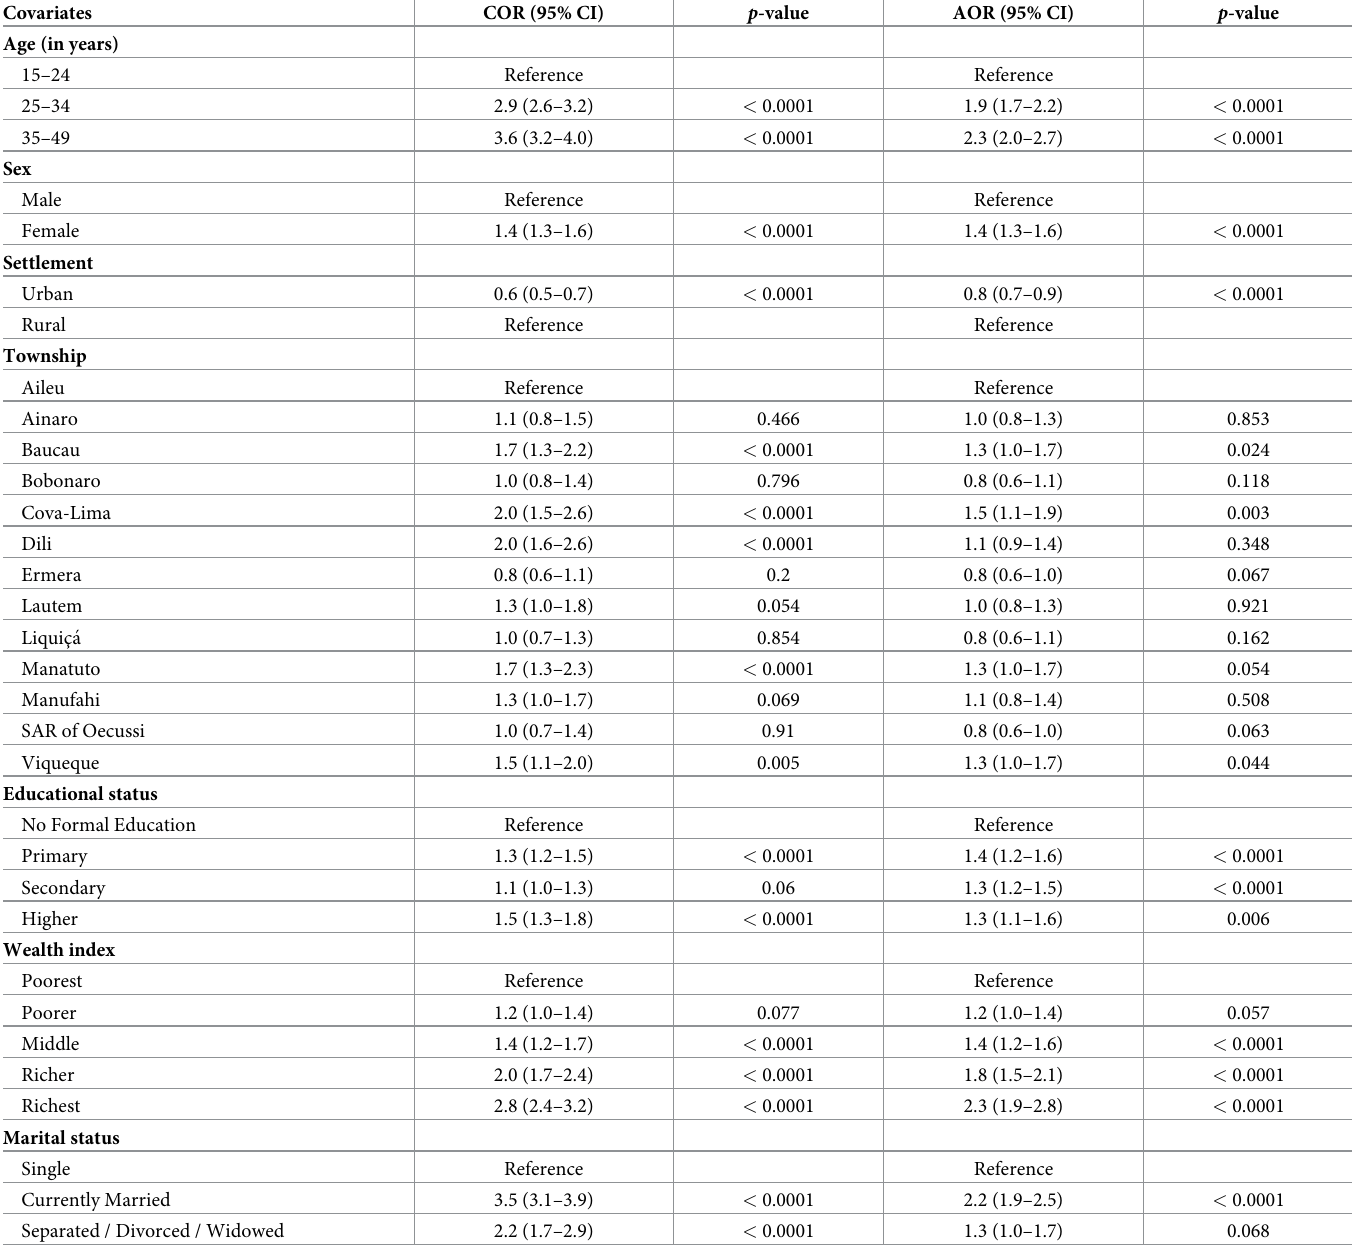
Table 3. Crude and adjusted odds ratio (95% CI) estimates of overweight/obesity compared to normal weight by respondent background characteristics, TLDHS 2016. Covariates COR (95%